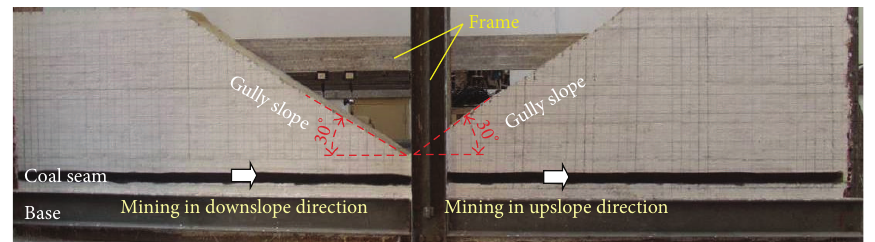
Figure 4: The original model for the physical experiment.